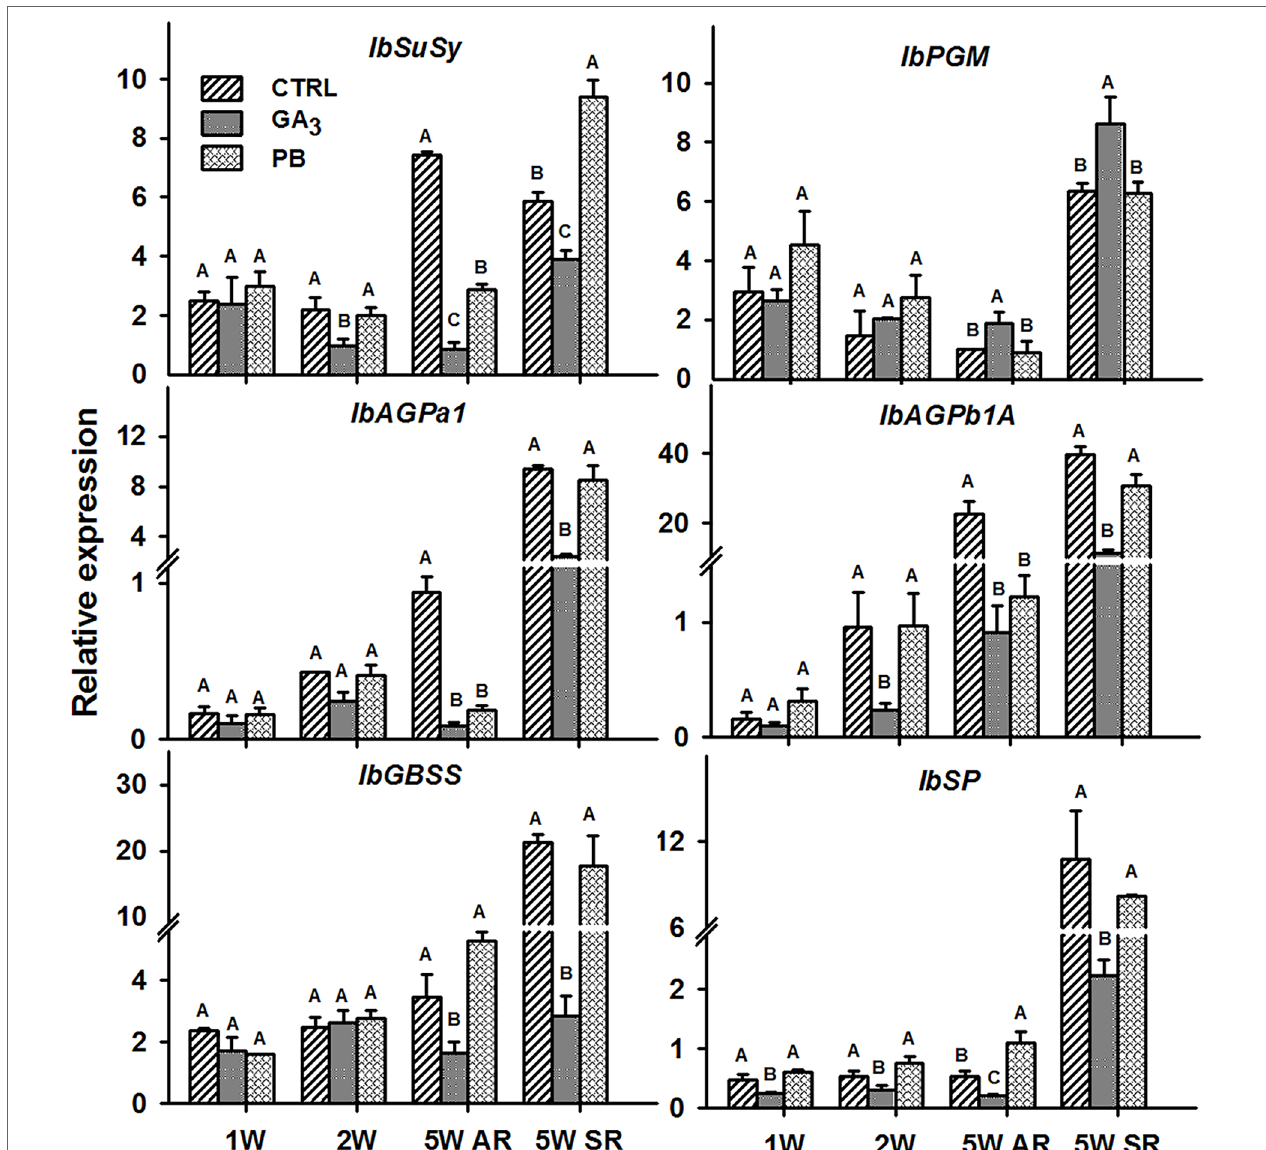
FiGURe 12 | The effect of GA 3 application on expression profiles of sweetpotato “ Georgia Jet ” carbohydrate metabolism and starch biosynthesis orthologs/genes in adventitious roots (AR) and storage-roots (SR). Expression/transcript levels were measured at 1W, 2W and 5W after planting for AR and at 5W for SR, using qRT- PCR analyses and values were normalized relative to the expression levels of phospholipase D1a. qRT-PCR data are mean (± SE) of three independent biological replicates (each representing roots pooled from four plants). Significance analysis was performed by using student’s t-test ( P ≤ 0.05 ), where unlike letters represent significant differences between treatments within a group. Control (treated with water); GA 3 , application of 50 ppm gibberellic acid 3 for two weeks; PB, application of 5 ppm paclobutrazol for two weeks.